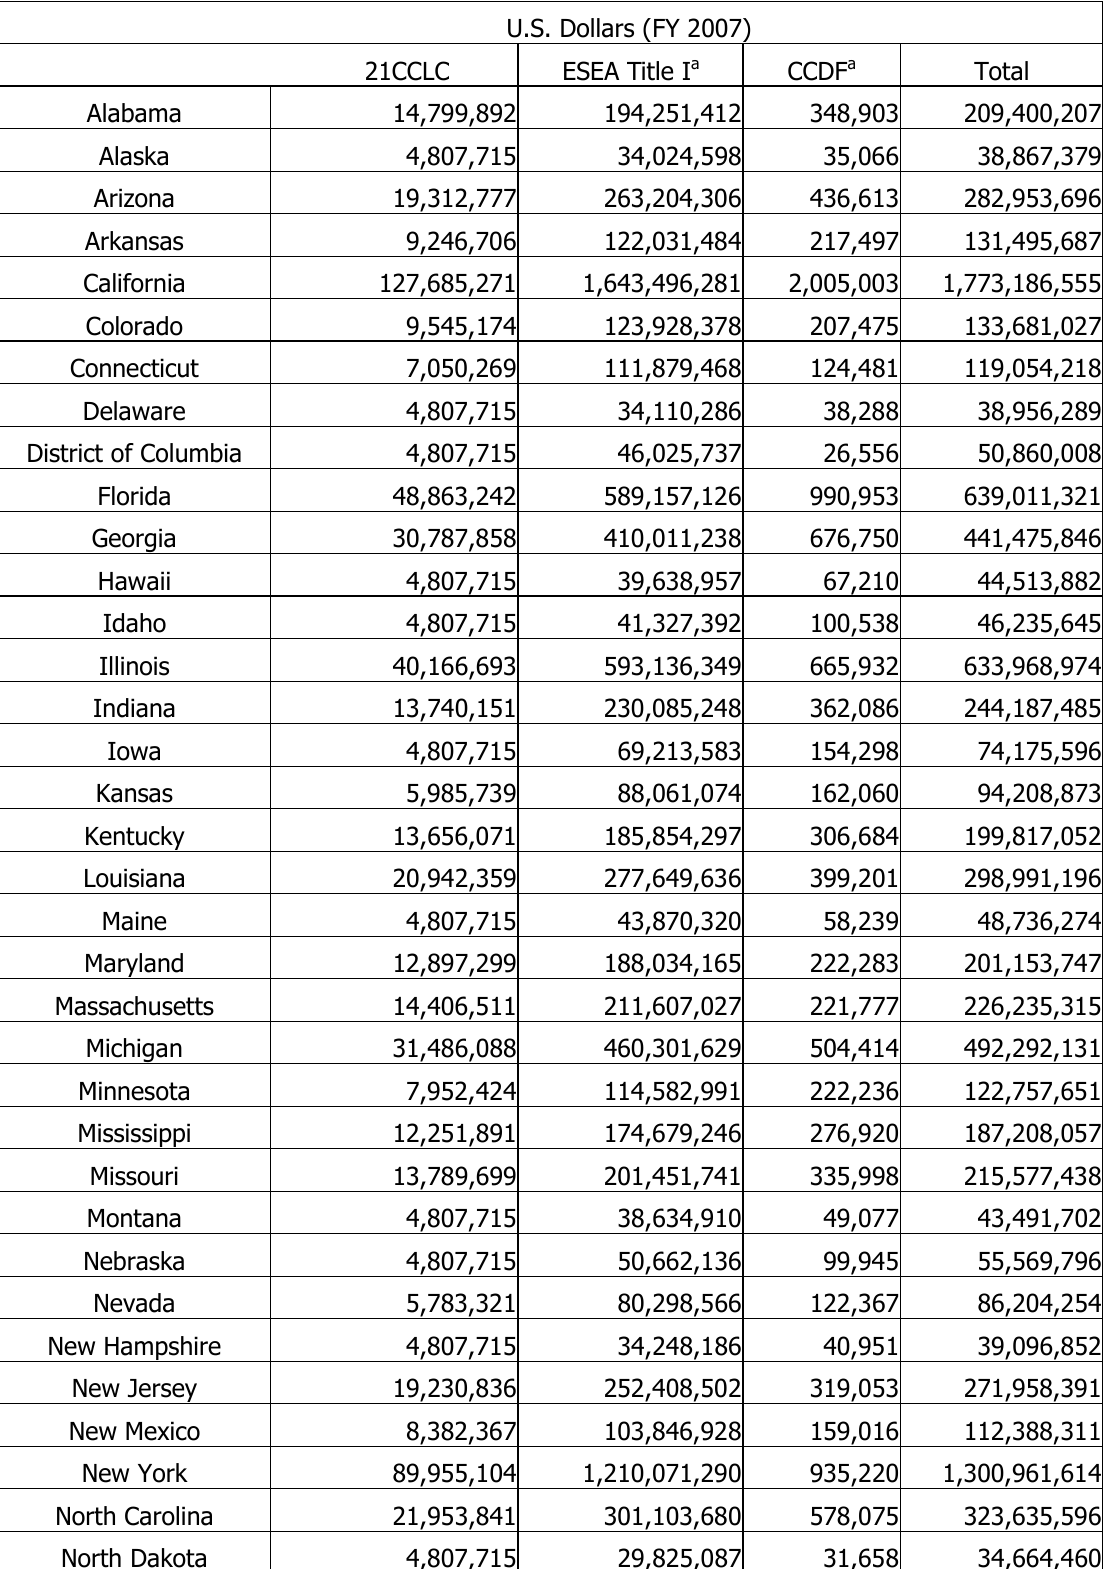
State-level Funding for Afterschool Programs and School-age Child